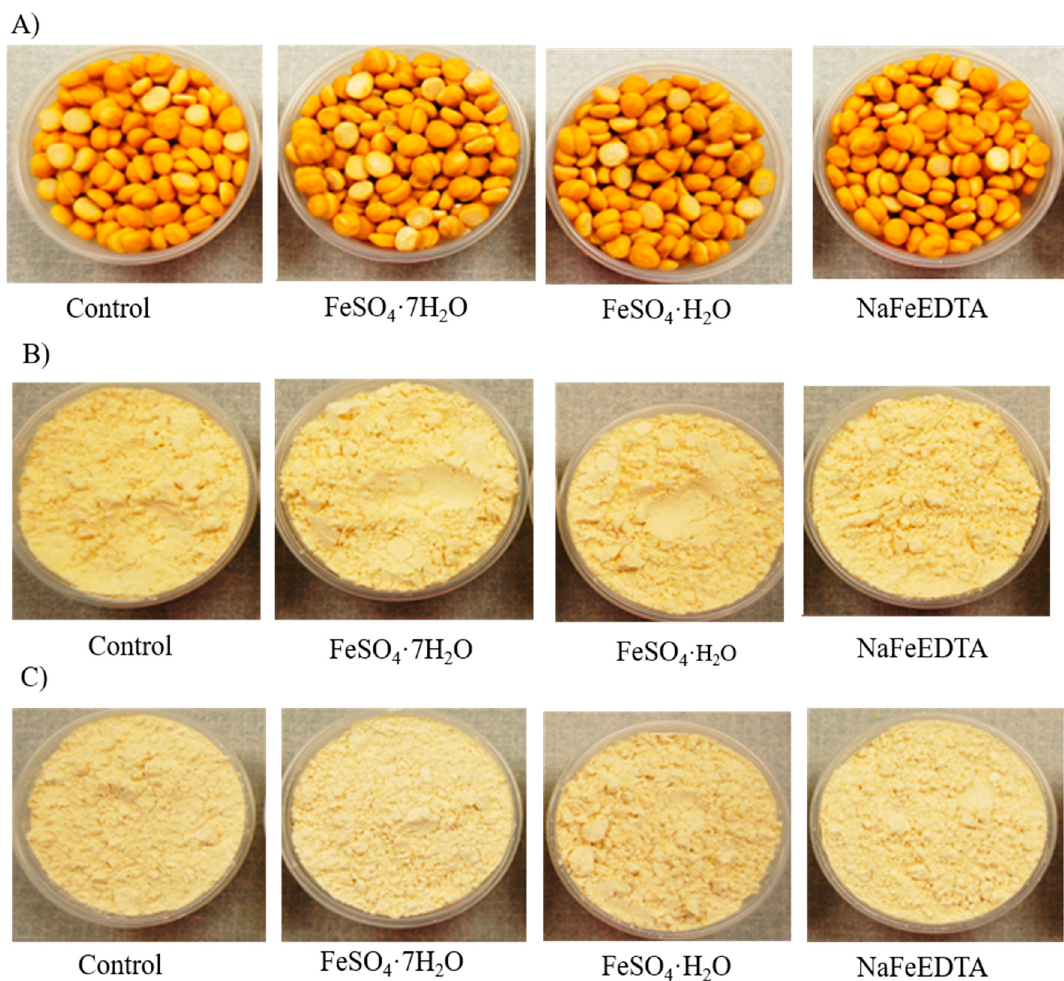
Figure 2. Images of unfortified (control) and Fe-fortified ( A ) uncooked split desi seeds, ( B ) uncooked desi flour and ( C ) uncooked kabuli flour fortified with fortificant solutions containing a 2000 µg g − 1 of Fe and prepared from three different Fe salts (FeSO 4 ·7H 2 O, FeSO 4 ·H 2 O and NaFeEDTA). Data on the appearance, odor and overall acceptability of the three uncooked products (split desi seed, desi flour and kabuli flour) are presented in Table 3.